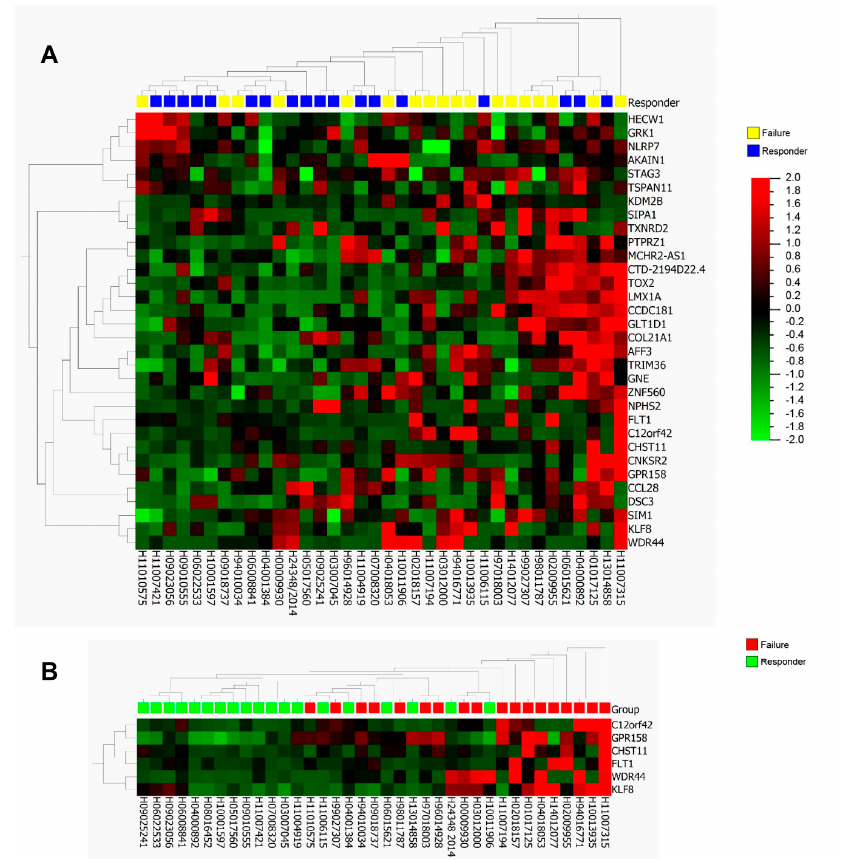
Figure 2. Bisulfite-sequencing (BSP) of identified top DMRs between BCG responders and failures using an internal validation cohort. ( A ) Hierarchical clustering of the BSP results of selected top DMRs results in separate clusters for BCG failures and responders (color corresponds to percentage of methylation, from red = 100% methylation to green = 0% methylation). ( B ) Six target regions identified with class comparison analysis in the promoters of GPR158 , KLF8 , C12orf42 , WDR44 , FLT1, and CHST11 with a significantly differential methylation status between the two patient cohorts.